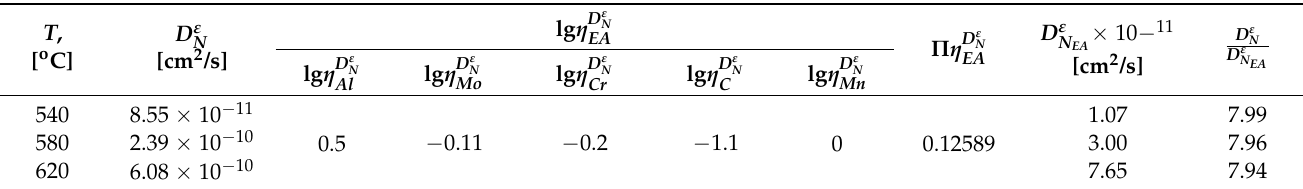
Table 5. The calculation results of the nitrogen diffusion coefficient in the 34CrAlMo5 nitralloy steel ε solid solution, at different